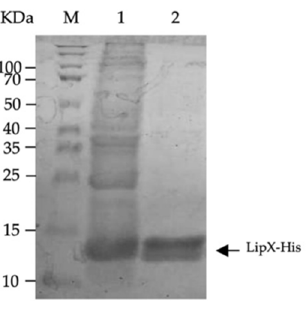
Figure 1. LipX-His protein isolation. Lane 1, cell lysates from the 1 mM IPTG induction culture of E. coli BL21 containing the pET28- lipX plasmid; Lane 2, Protein isolated using the Ni-NTA affinity column from the culture of E. coli BL21 containing the pET28- lipX plasmid inducted by 1 mM of IPTG. KDa—kilo Dalton; M—marker.